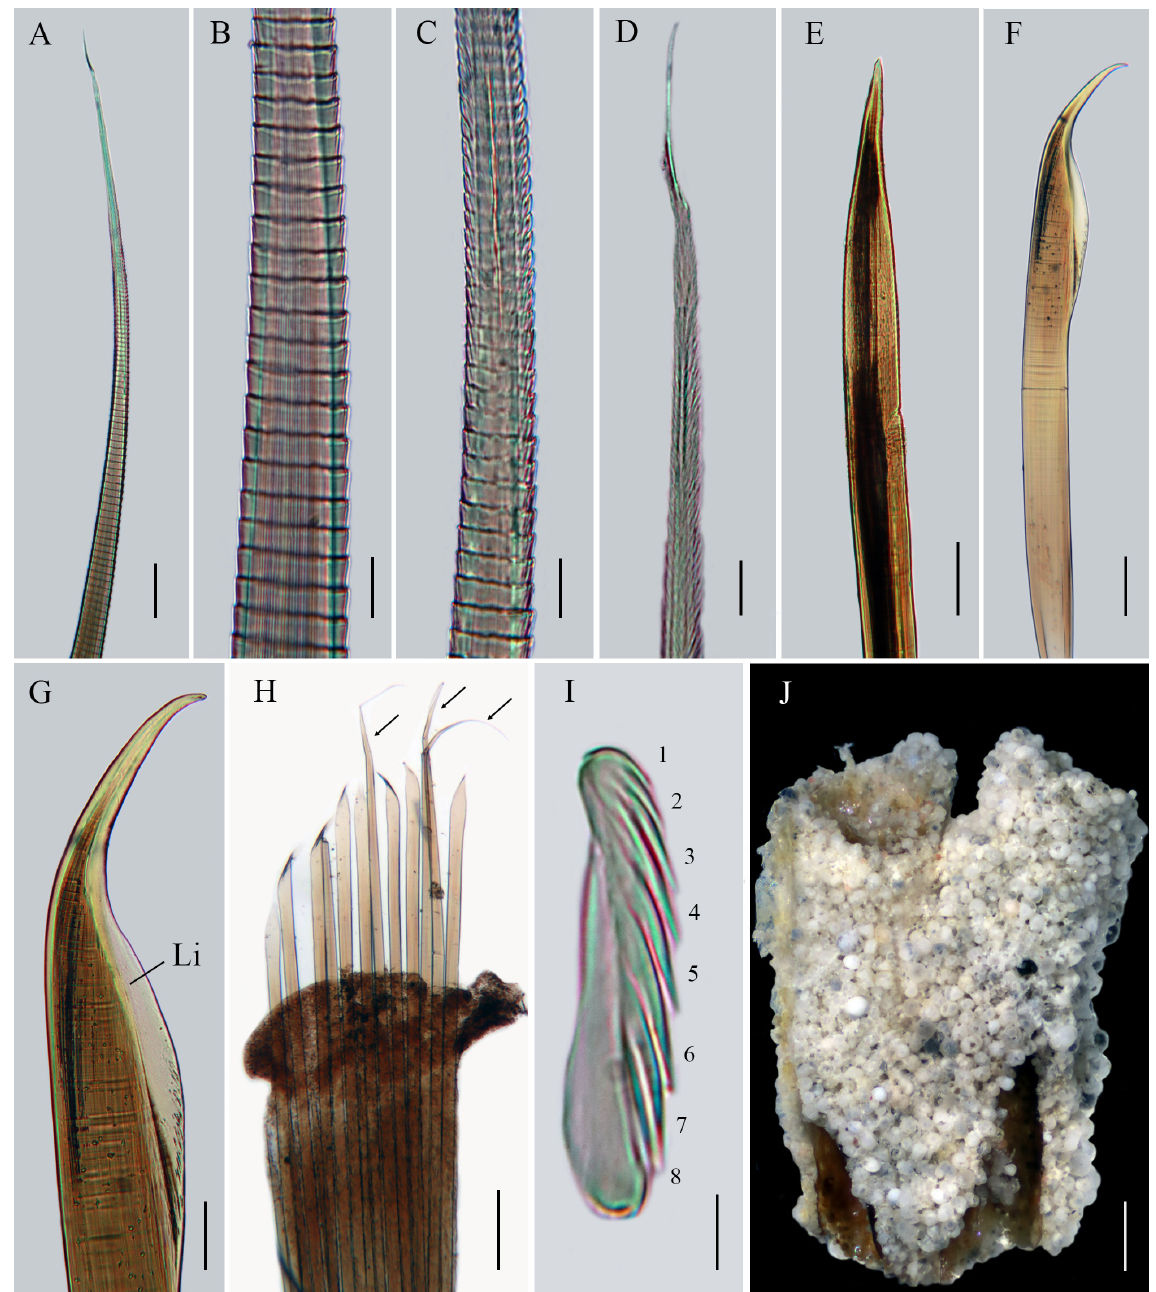
Fig. 14. Phalacrostemma perkinsi Kirtley, 1994 (UMML-22.1191). A . Outer palea. B . Distal region of outer palea. C . Middle region of outer palea. D . Tip of outer palea. E . Inner palea. F . Nuchal hook. G . Detail of nuchal hook. H . Parathoracic notochaetae. I . Uncini. J . Tubes. Abbreviation: Li = limbation. The arrows indicate capillary chaetae. Numbers indicate the rows of teeth. Scale bars: A, E–F, H = 200 µm; B–D = 20 µm; G = 100 µm; I = 10 µm; J = 2